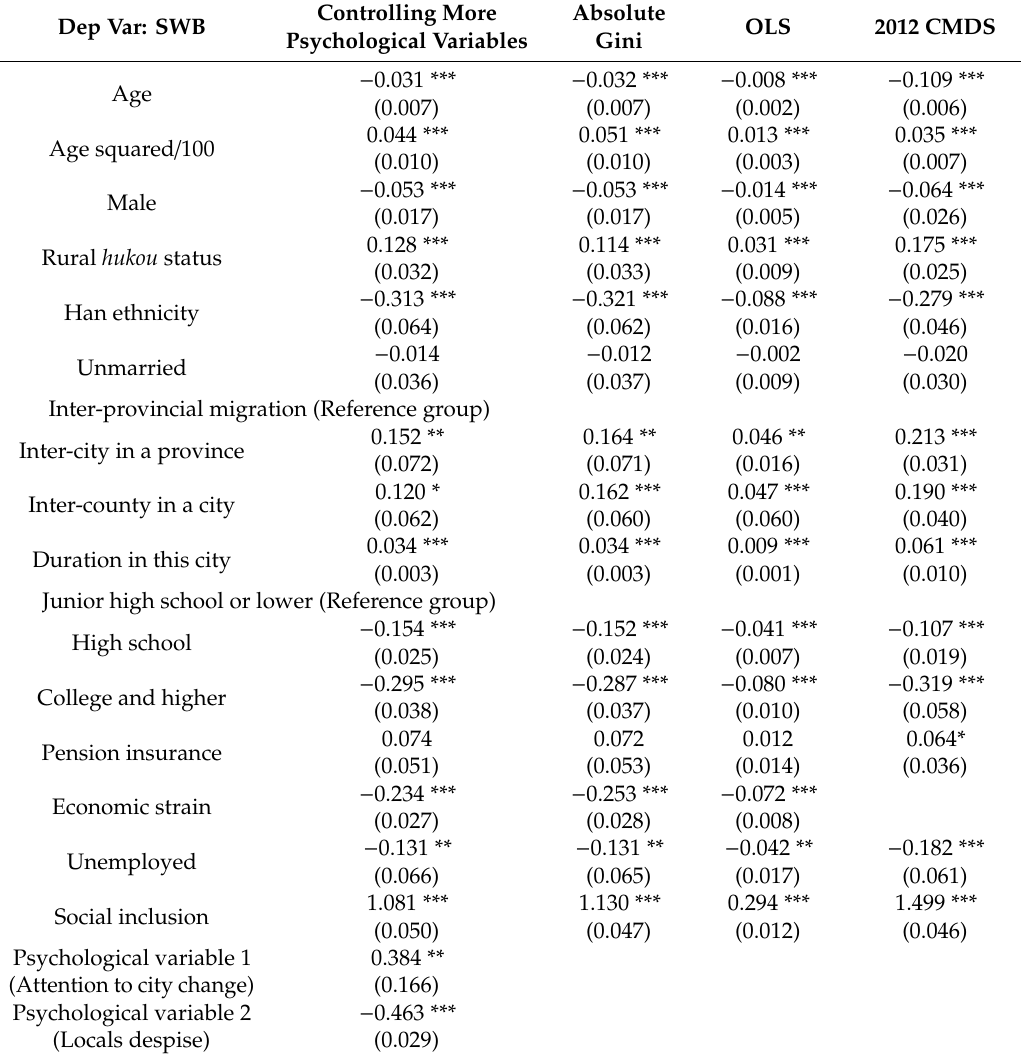
Table A3. The results of the omitted controls in Table 6.